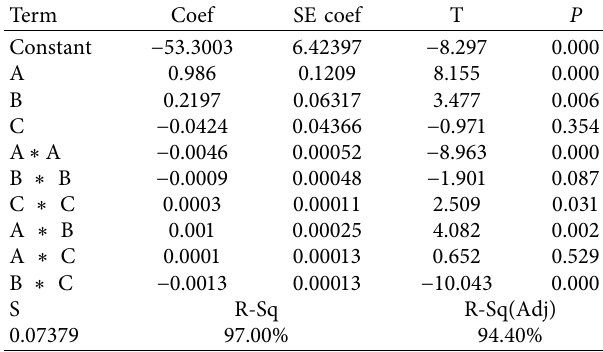
Table 7: Results obtained from experiment. Exp. no.